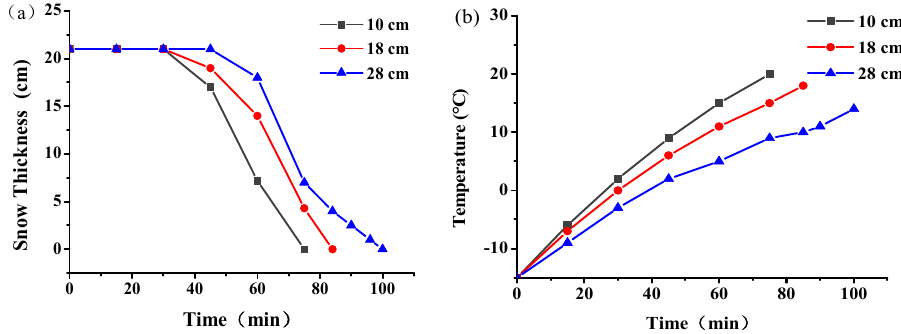
Figure 6. Snowmelt effect of graphene conductive concrete with different electrode spacing; ( a ) snow thickness ( b ) plate temperature rise.